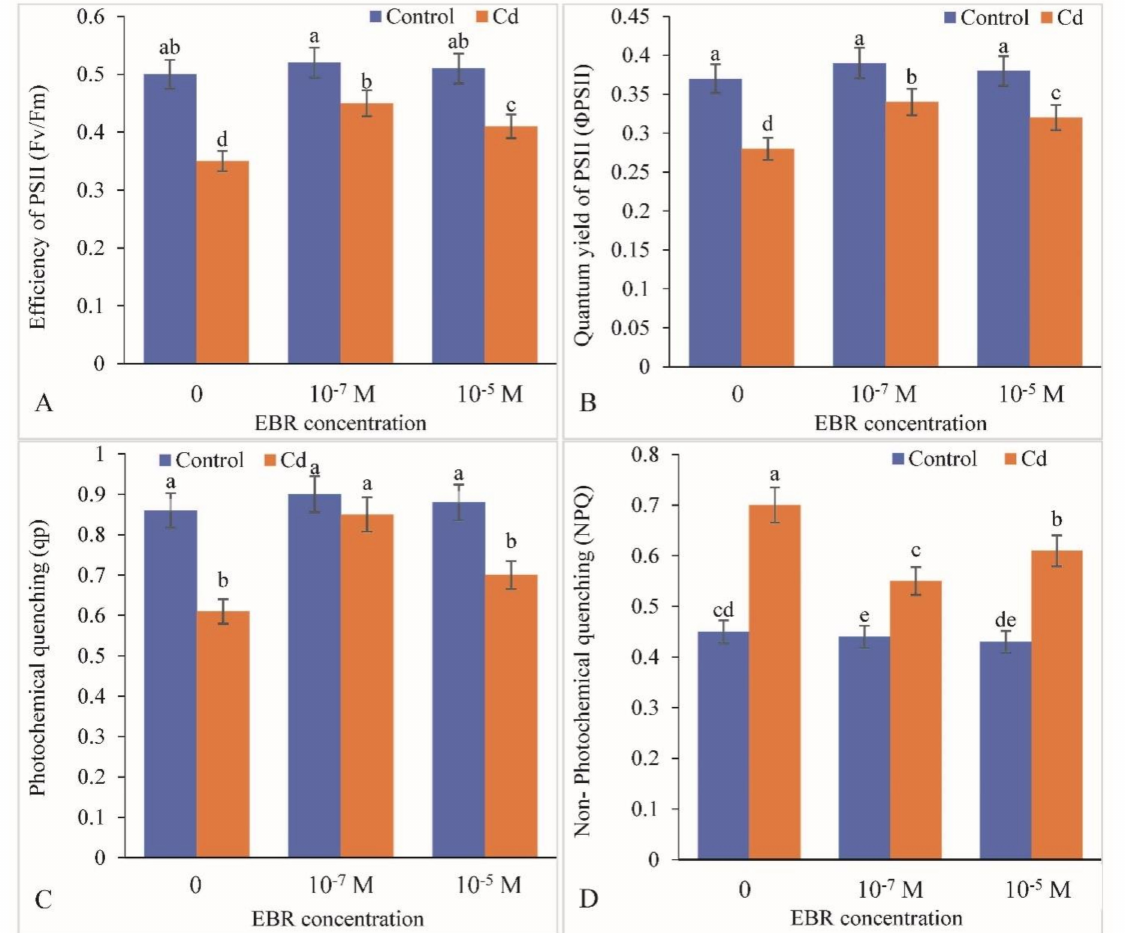
Figure 4. Supplementation of 24-Epibrassinolide boosts ( A ) Fv / Fm, ( B ) Φ PSII, ( C ) qp and ( D ) declines NPQ in the leaves of B. juncea under Cd (200 µ M) stress. Values with di ff erent letters above the bars are significantly di ff erent at each measured time point ( p < 0.05) (Mean ±